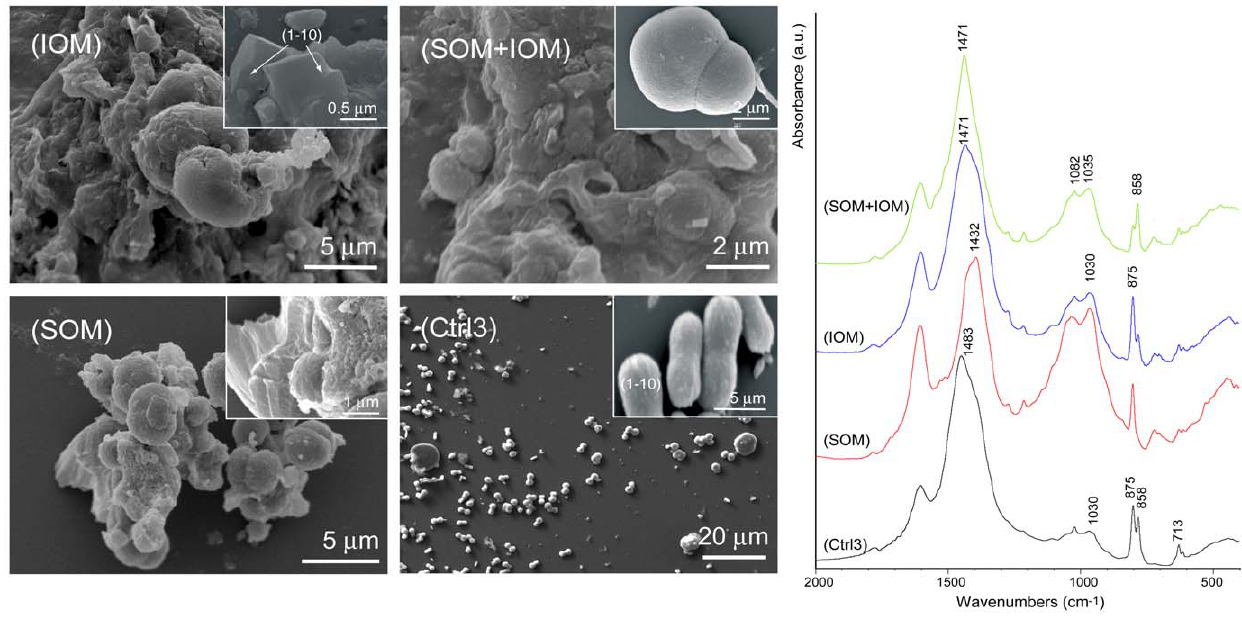
Figure 6. Calcium carbonate crystallization experiments. Crystallization experiments of calcium carbonate from 10 mM CaCl 2 solution with a Mg/Ca molar ratio equal to 3 (Ctrl3) and in the presence of soluble organic matrix (SOM), insoluble organic matrix (IOM) or both of these (IOM + SOM). The Miller indexes of calcite faces are indicated. left Scanning electron microscope images, the insets show sample’s details right FTIR spectra of the precipitated. The main absorption bands of calcium carbonate are indicated.